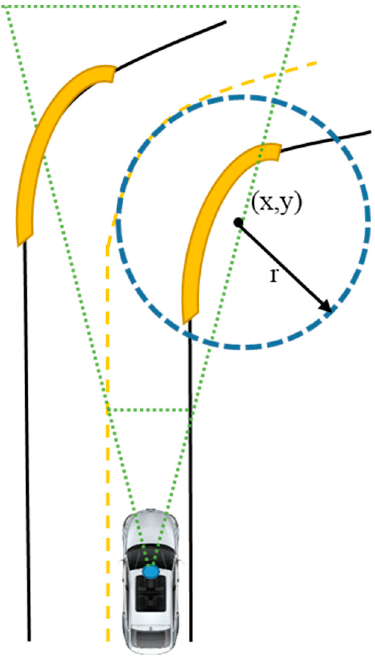
Figure 7. Circle model of the road turning.